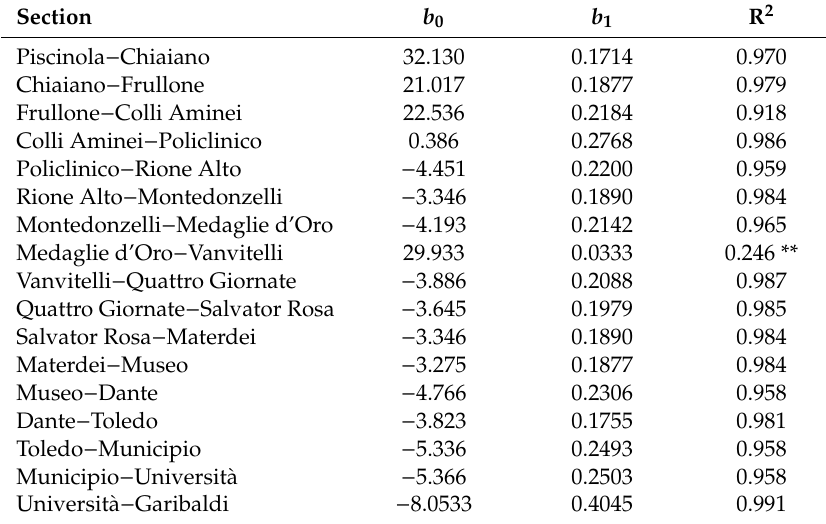
Table 2. Coe ffi cients of Equation (6) for each